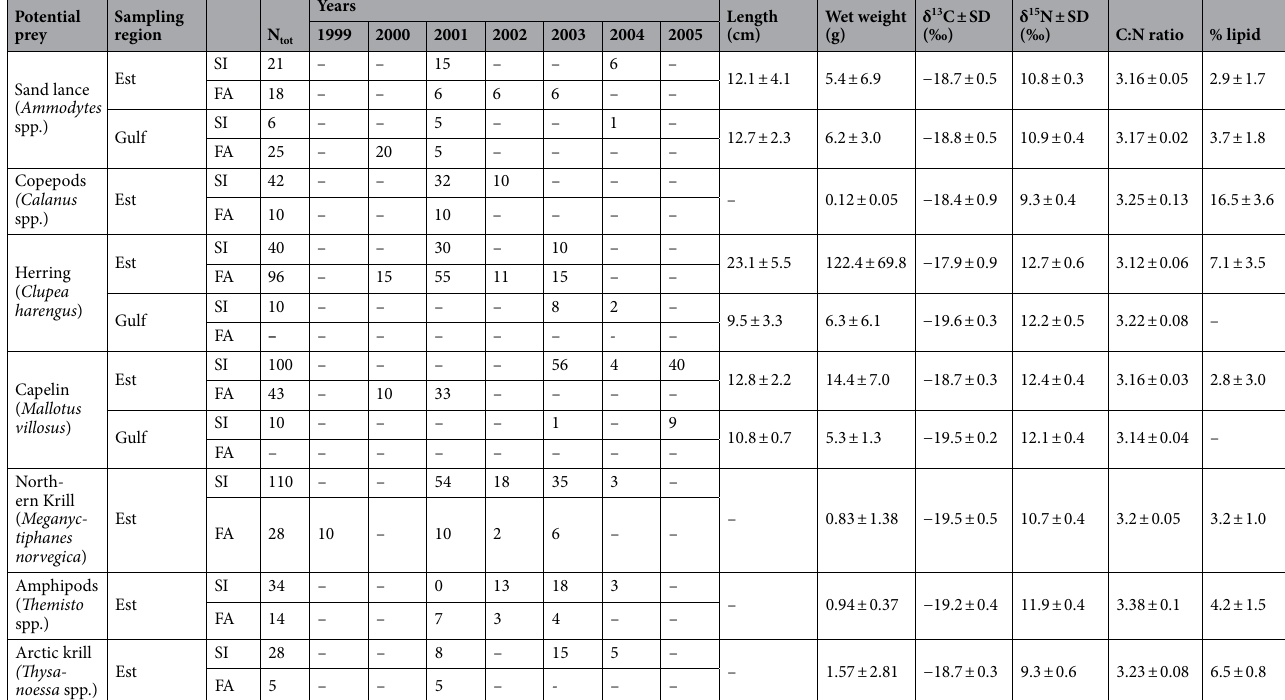
Table 1. Sample size, descriptive characteristics and mean δ 13 C and δ 15 N values for fin whale potential prey collected between 1999 and 2005 in the Estuary and Gulf of St. Lawrence and analysed for stable isotope (SI) or fatty acid (FA) analyses. Central tendency is expressed as the mean (± SD). Isotopic values are uncorrected for isotopic discrimination, but are corrected for lipid